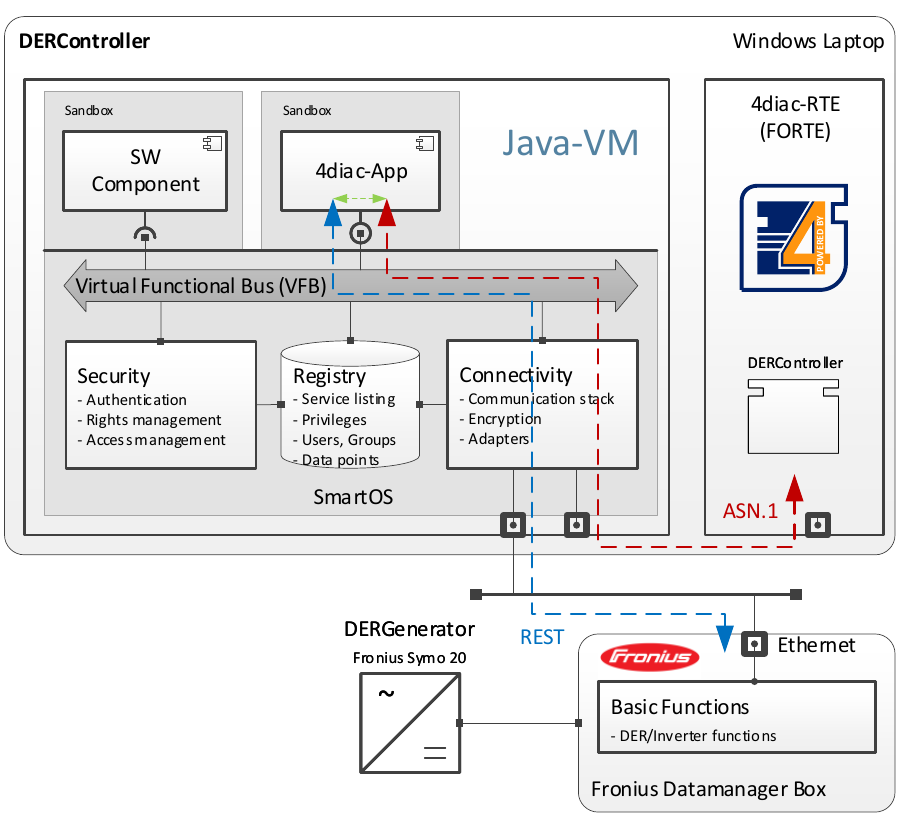
Figure 23. Setup of the SmartOS and 4diac on the distributed energy resources (DER) Controller laptop.